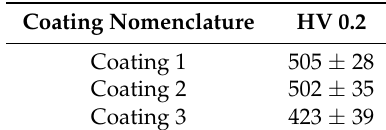
Table 2. Coating hardness values.